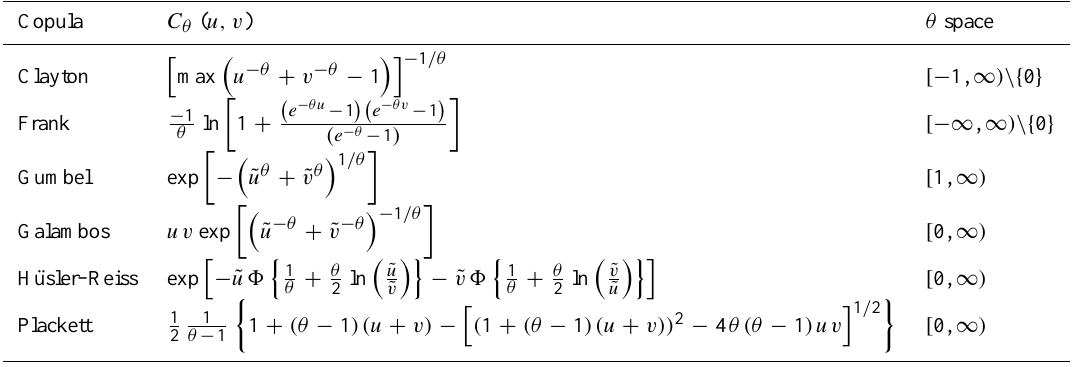
Table 3. Copula functions and parameter space of the considered copulas.